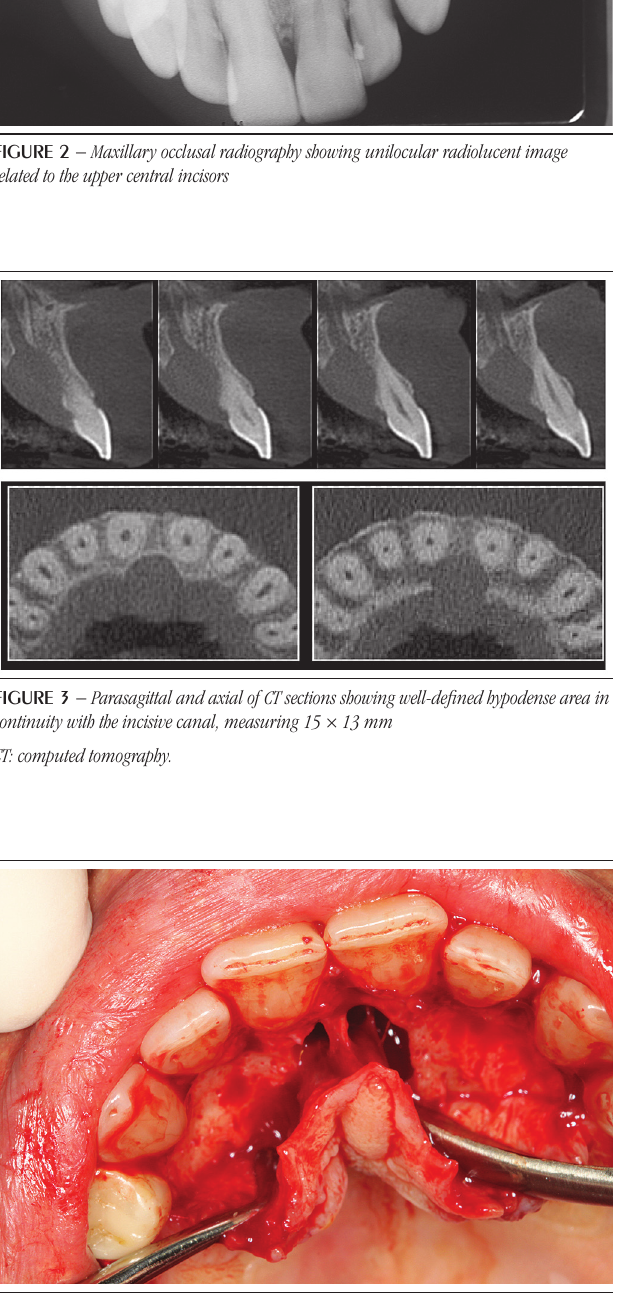
figurE 4 − Intrasulcular incision and detachment of the palatal